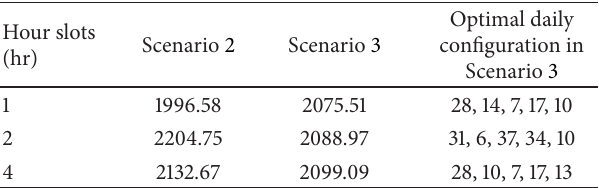
Table 3: Comparison of the total daily power loss among one, two, and four hours’ slots.